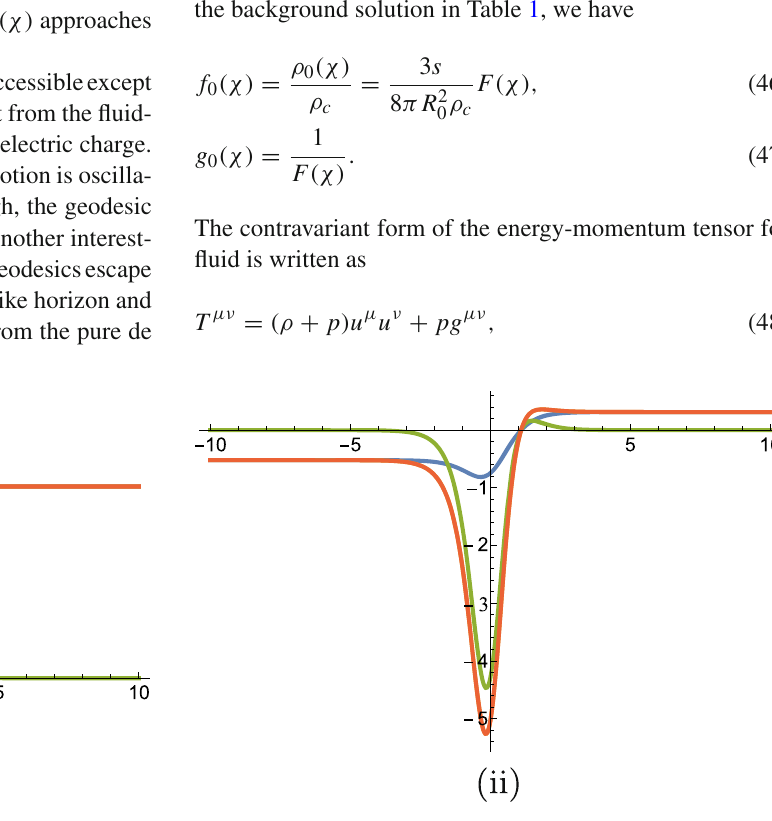
Fig. 5 Plot of effective potential V (χ) for S 3 -II. [ L = 0 (blue), L = 4 (red) for timelike.] (i) RN black-hole type solution: K = 1, Q = 1, R 0 = 0 . 4, L null = 4. For the low energy level ( ˜ E ), the geodesic motion is similar to that of S 3 -I (i), which oscillates in the infinite spacetime tower. For the intermediate energy level, the geodesic motion can reach the inner static region behind the inner horizon. For the high energy